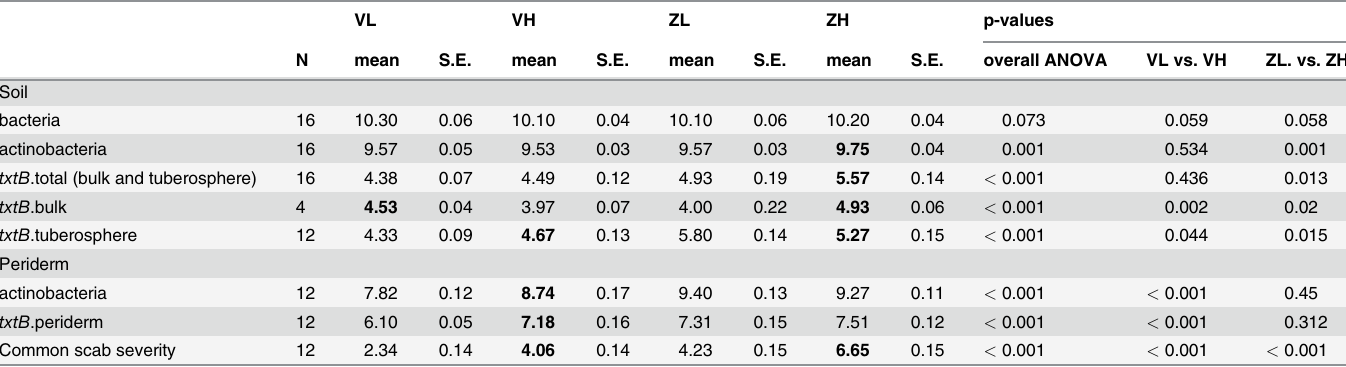
Table 2. Biological characteristics.